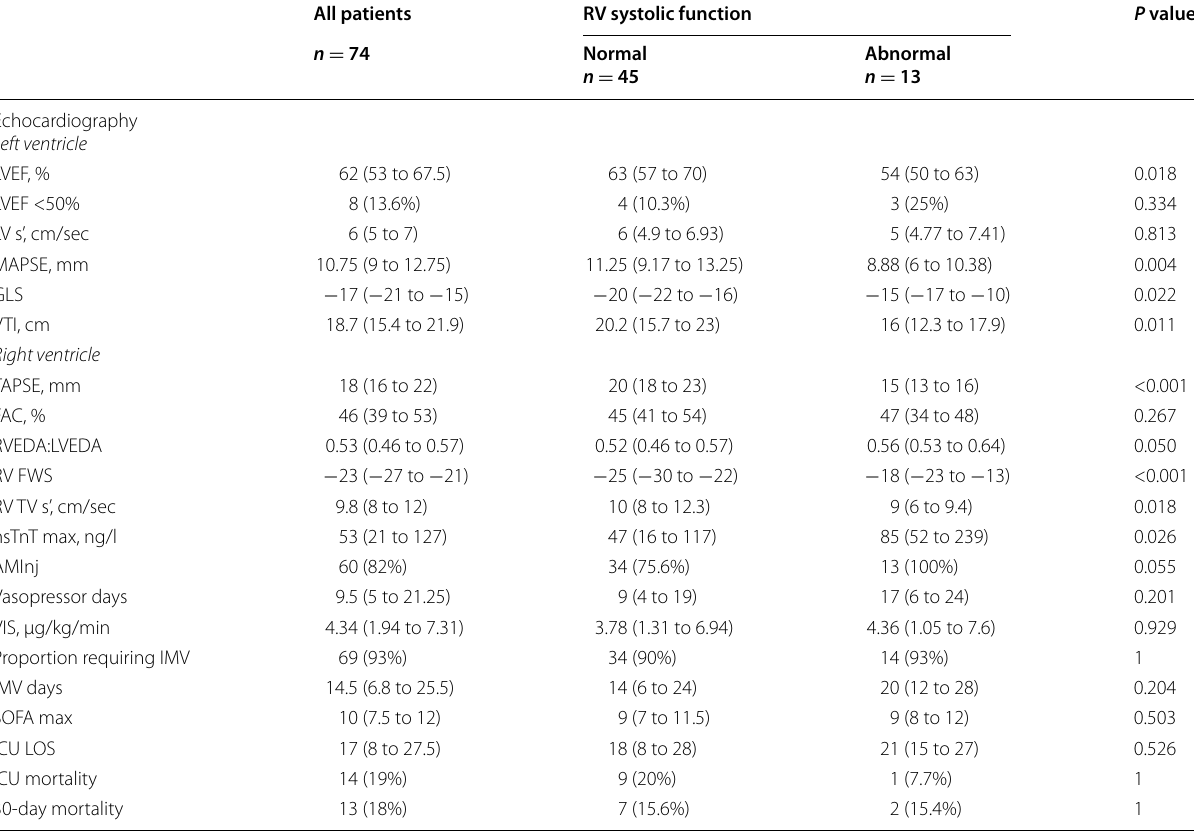
P values refer to normal vs. abnormal systolic function LVEF left ventricular ejection fraction, MV s’ mitral valve tissue colour doppler systolic velocity (average of septal and lateral measurements), MAPSE mitral annular plane systolic excursion, GLS global longitudinal strain, VTI velocity time integral measured at the left ventricular outflow tract, TAPSE tricuspid annular plane systolic excursion, FAC fractional area change, EDA end diastolic area, FWS free wall strain, TV s’ tricuspid valve tissue colour doppler systolic velocity (free wall), hsTnT high sensitivity Troponin T, VIS vasopressor–inotrope score, IMV invasive mechanical ventilation. P values refer to normal vs. abnormal RV systolic function